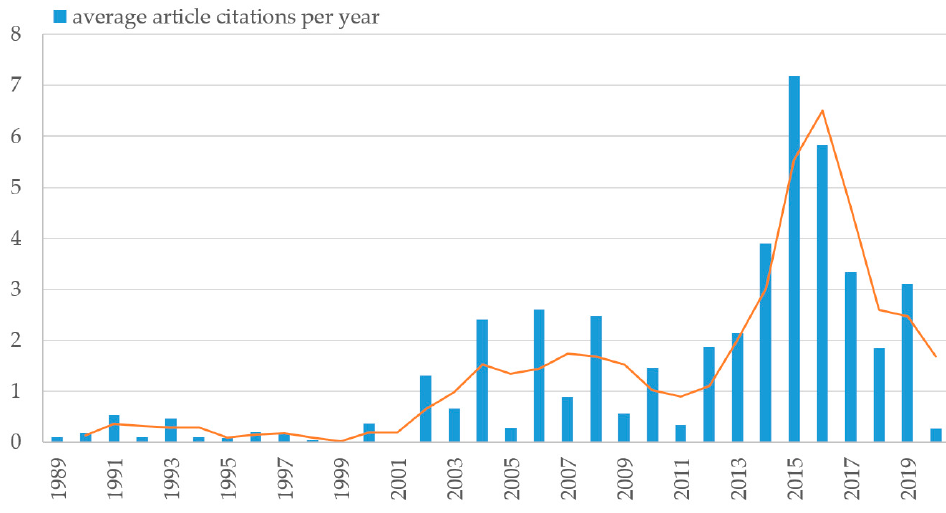
Figure 4. Average citations per year.